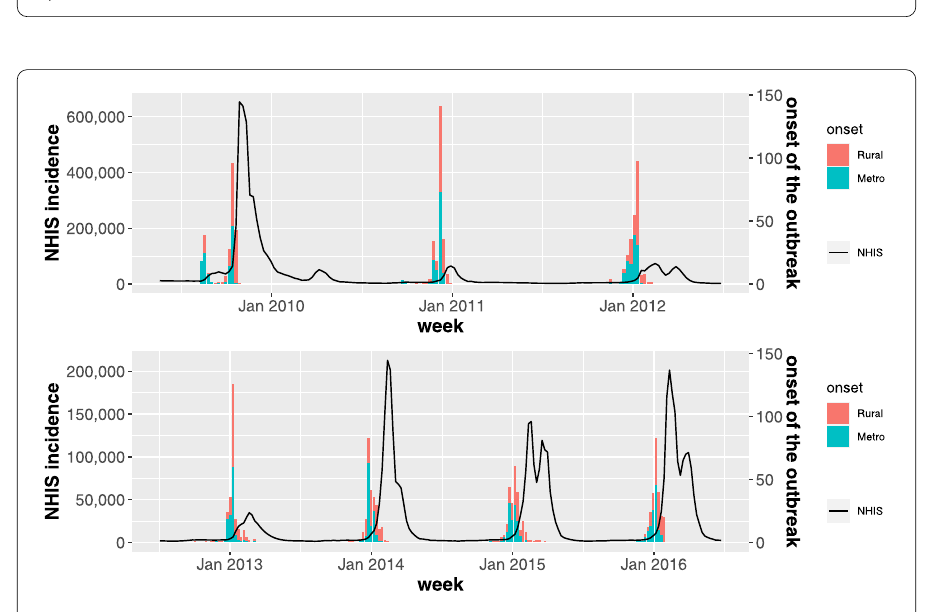
Figure 8 The histogram of the outbreak start weeks. The histogram shows the number of city-county-districts where the influenza outbreak has started in that week. As the same as Fig. 6, the black solid line represents the number of new patients